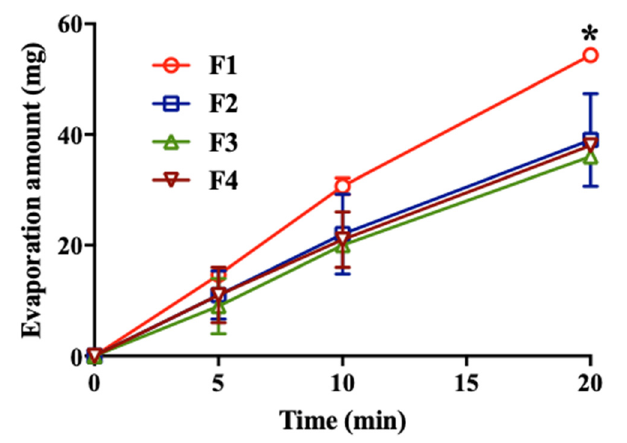
Figure 4. Water retention ability of formulations. The filter papers were soaked with 0.2 mL of each the lubricants and left in an open container at 25 ◦ C and a humidity of 47%. * p < 0.05 versus F1 to the of the lubricants and left in an open container at 25 °C and a humidity of 47%. * p < 0.05 versus F1 to other the other formulations.